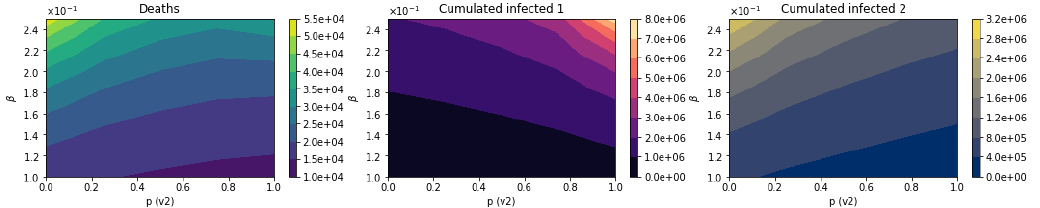
Figure 12. Total number of deaths and the cumulative number of infected people for each age group.